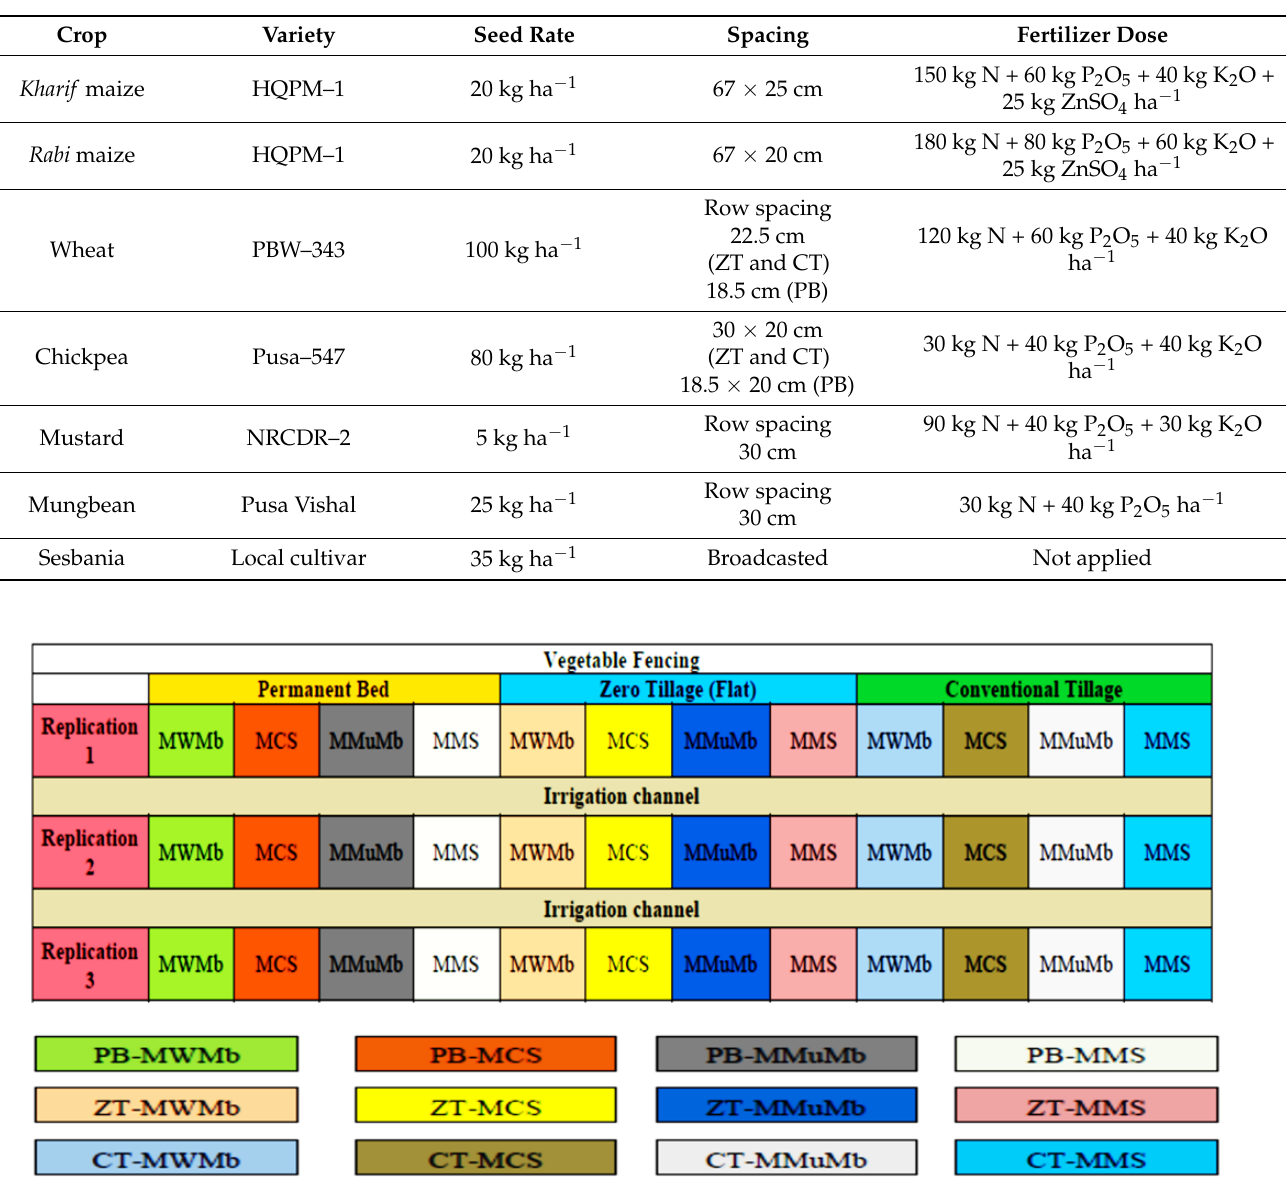
Table 2. Crop establishment and management details.